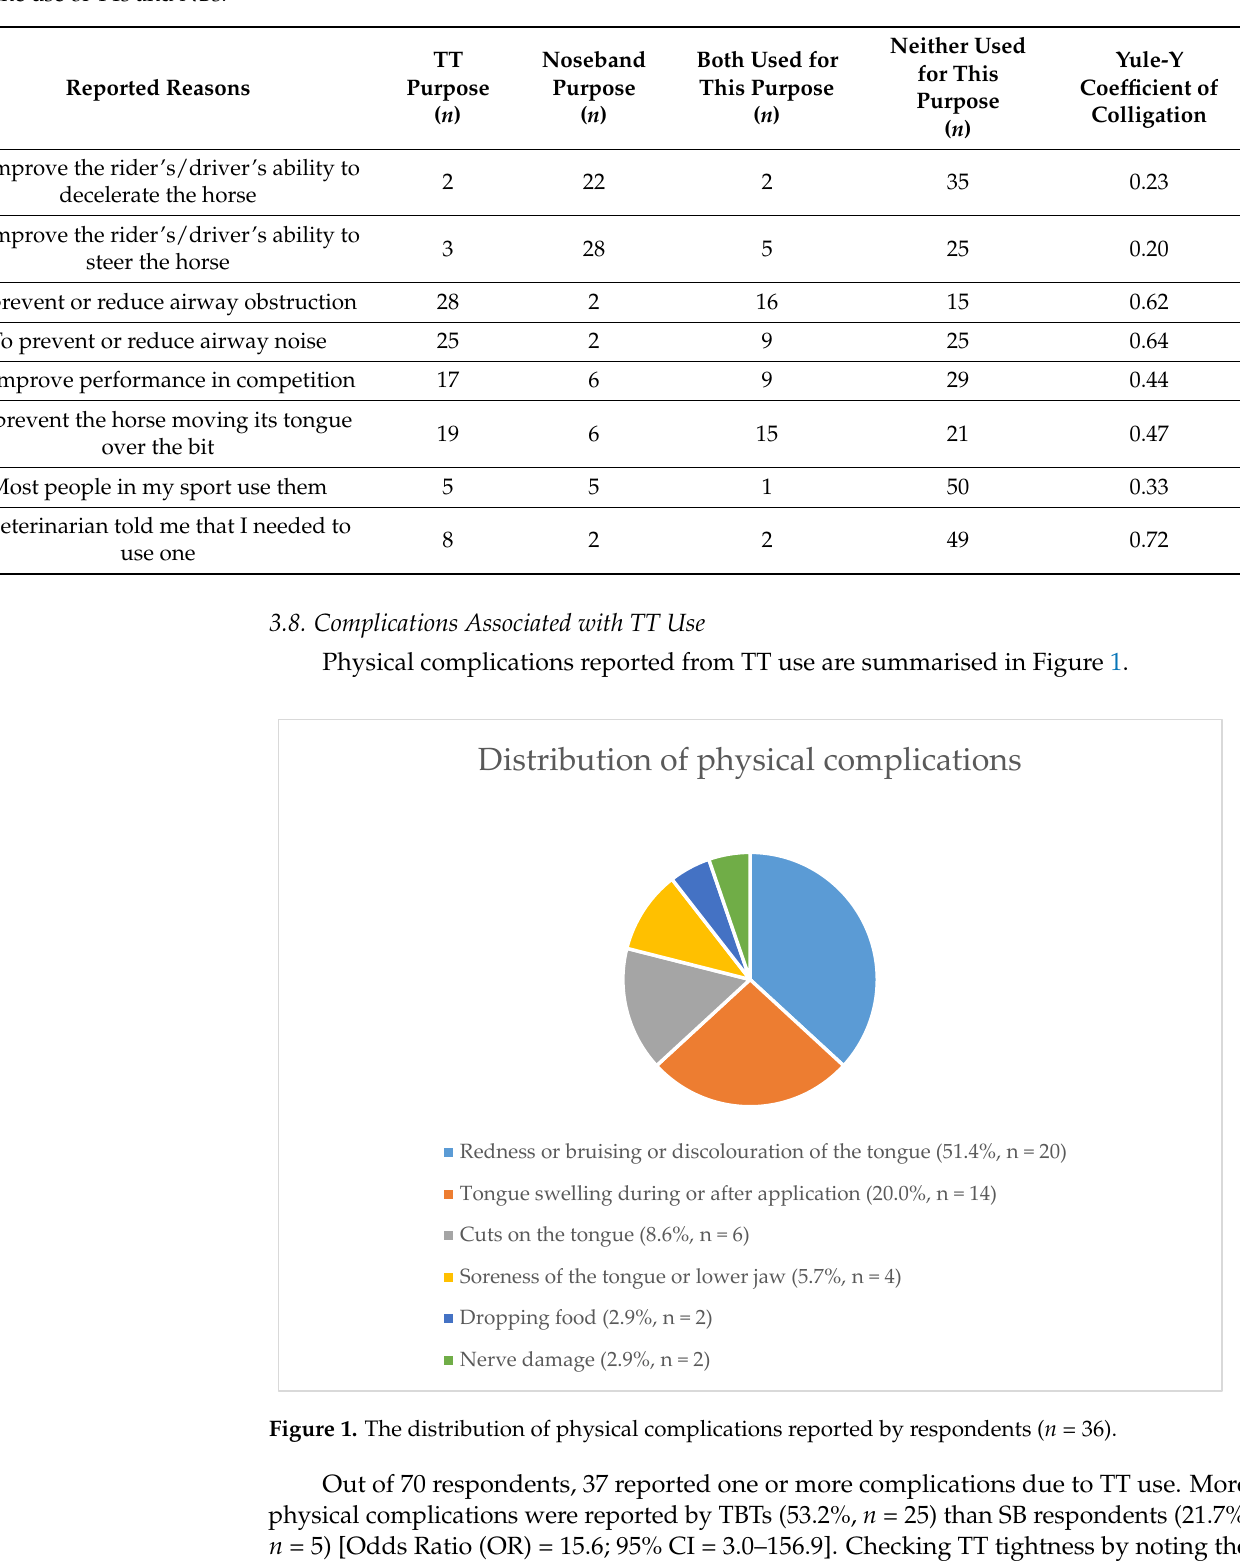
Table 4. Agreement of reasons among users ( n = 61) of both TTs and NBs. Respondents were able to select more than one reason for using both items of gear. Yule-Y coefficient of colligation measures the association between the stated reasons for the use of TTs and NBs.